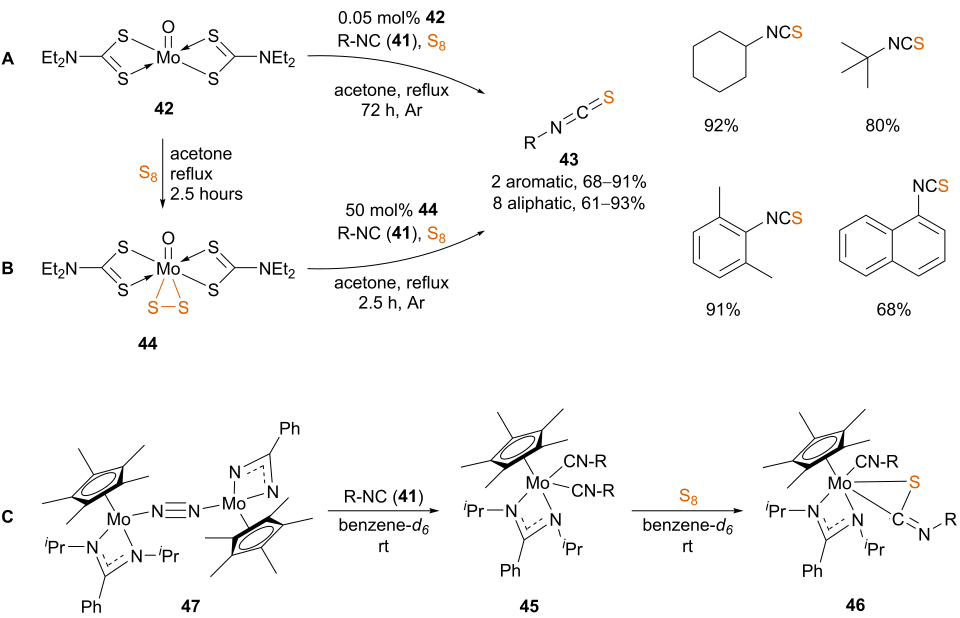
Scheme 9. Molybdenum-catalyzed transformation of isocyanides ( 41 ) to ITCs ( 43 ) with selected examples and mechanistic insights ([69,70]). ( A , B ) are based on Scheme 1 from [71]. ( C ) is based on Schemes 1 and 2 from [70].